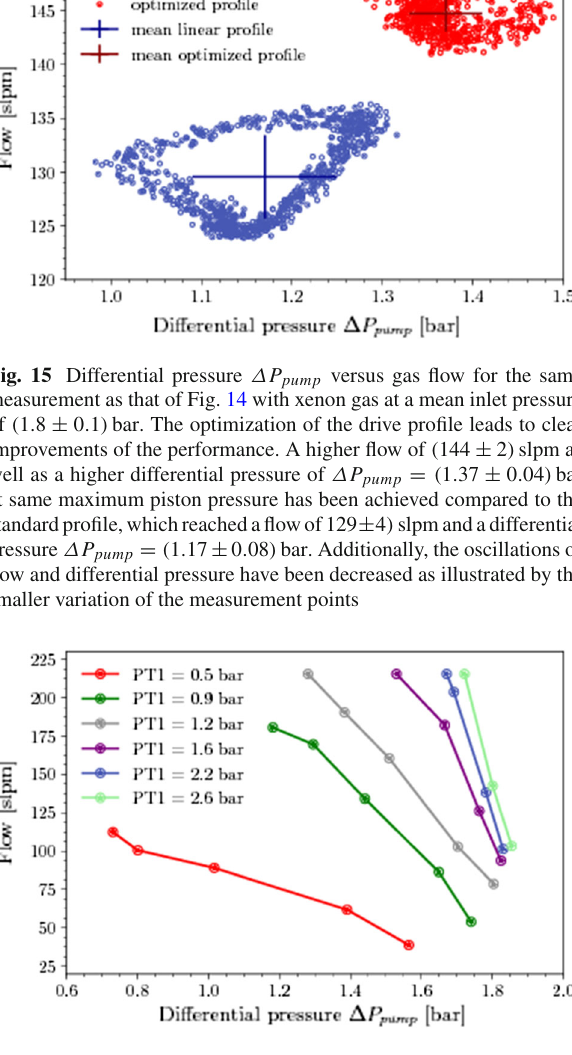
Fig. 16 Performance of the pump with argon for different inlet pres- sures. The flow was limited by the maximum point of the mass flow controller for inlet pressures of 1.2bar and higher